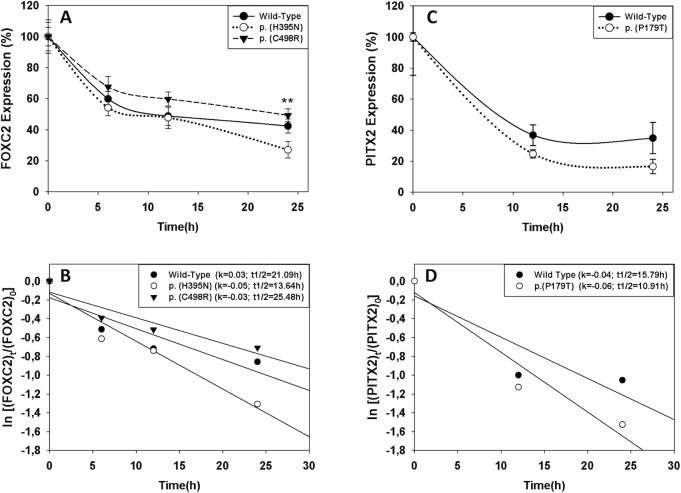
FOXC2 p.H395N variant decreases protein stability.Time course stability analysis of FOXC2 (A) and PITX2 (C) coding variants found in PCG patients was carried out by transient expression in HEK-293T cells. Transfected cells were treated with the protein synthesis inhibitor cycloheximide and the different recombinant proteins were detected by Western immunoblot using an anti-myc monoclonal antibody (Santa Cruz) at the indicated time points, as explained in Materials and Methods. Relative amounts of FOXC2 are expressed as a percentage of levels at time 0 h. The rate of decay and half-lives of the recombinant FOXC2 (B) and PITX2 (D) coding variants at the indicated time-points were determined from linear regression analysis as described in the Materials and Methods. Error bars correspond to the SD of three independent experiments carried out in triplicate. Asterisks indicate statistical significance compared to the control: p<0.01 (**). Two-way ANOVA followed by Tukey multiple-comparison test.